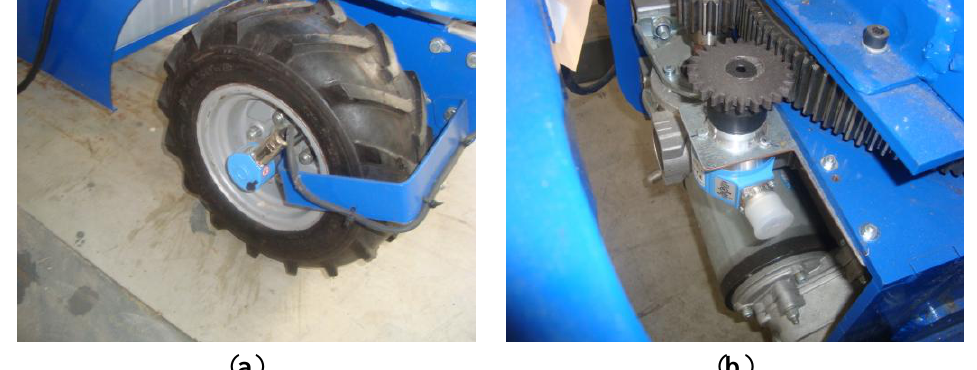
Figure 6. ( a ) Incremental encoder used to measure the angular velocity of the wheel (linear velocity of the vehicle). ( b ) Absolute encoder used to measure the angular position of the steering axle. Note the mechanical coupling